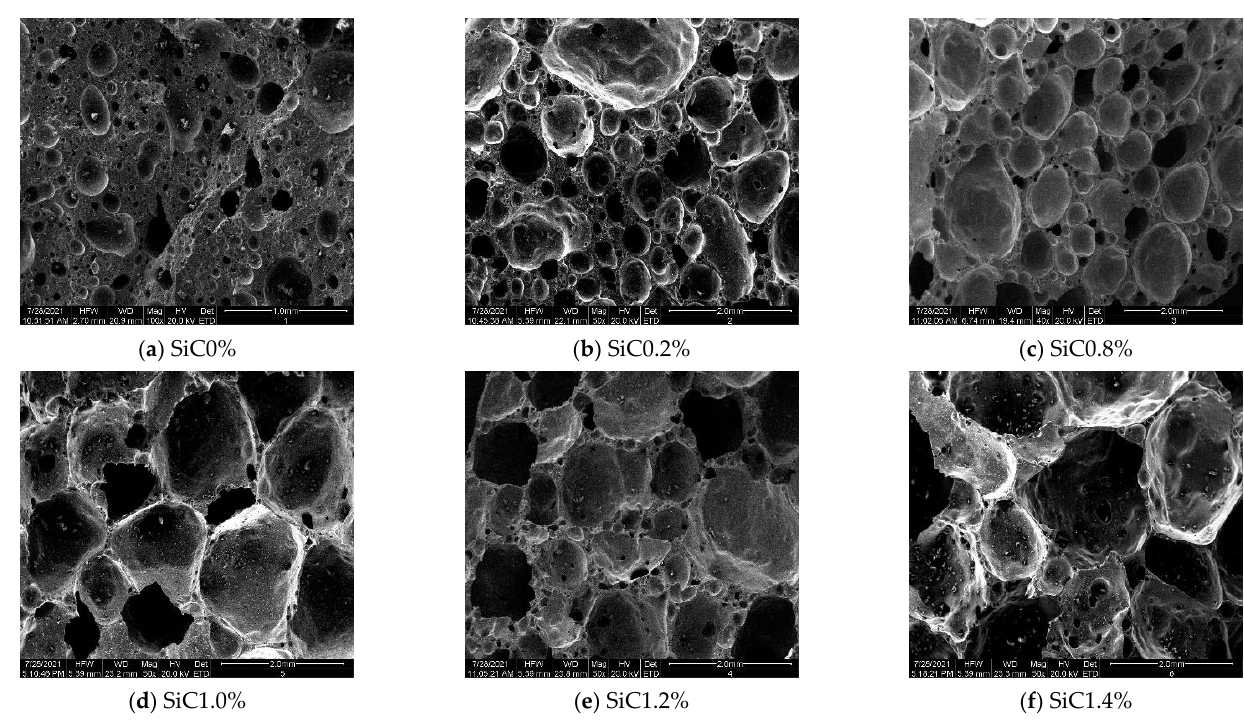
Figure 3. Scanning photomicrographs of internal pores in ceramsite with different SiC contents: ( a ) 0%, ( b ) 0.2%, ( c ) 0.8%, ( d ) 1.0%, ( e ) 1.2%, ( f ) 1.4%.